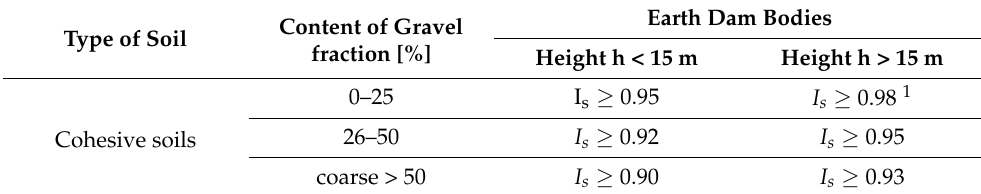
Table 3. Required compaction index [17,21].